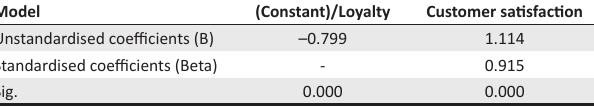
TABLE 5c: Influence of the intervening variable on the dependent variable. Coefficients.